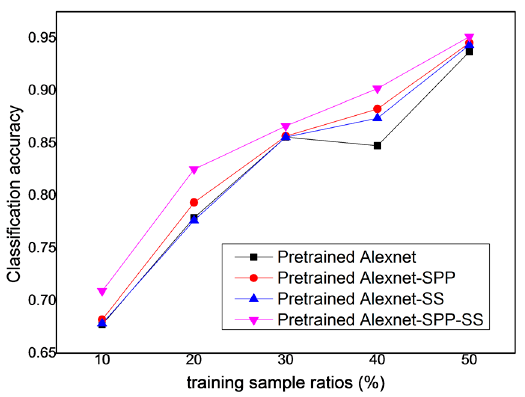
Figure 19. The influence of the training sample ratios with the different algorithms for the Google image dataset of SIRI-WHU.